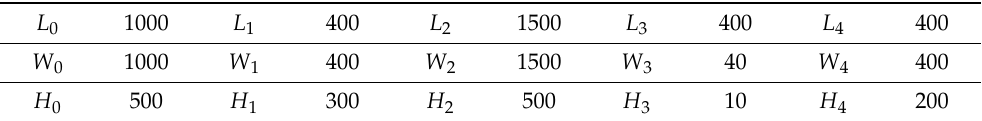
Table 2. The size of CCSB structure size ( µ